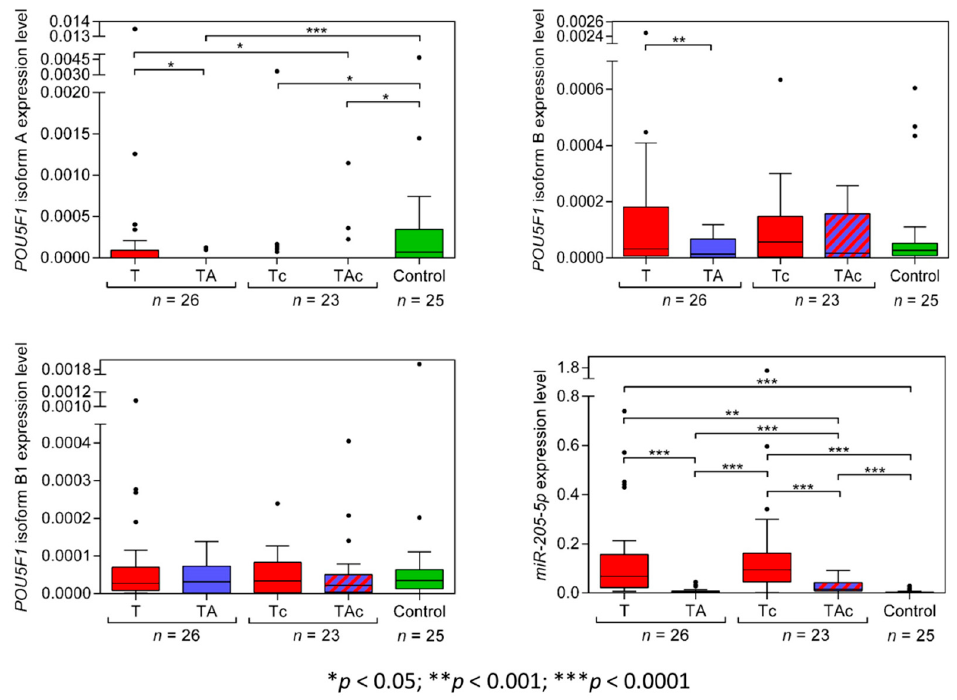
Figure 4. POU5F1 (isoforms A, B, B1) and miR-205-5p expression levels in tumors (T, red) and tumor-adjacent tissues without (TA, blue) or with (TAc, blue-dashed) cancer cell content in patients with EC, and in endometrial tissue in cancer-free patients with leiomyoma (Control, green).